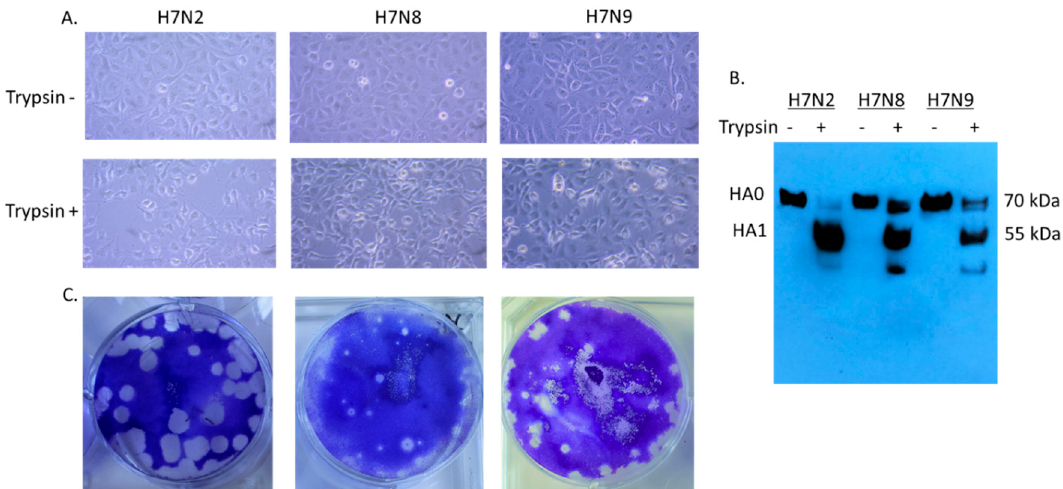
Figure 1. Infectivity of H7N2, H7N8, and H7N9 in MDCK (Madin–Darby canine kidney) cells. MDCK cells were individually infected with H7N2, H7N8, and H7N9 (MOI of 0.1 PFU/cell) in the presence or absence of trypsin. After 12 hpi, the infected cells were visualized directly by photomicroscopy, (20X) ( A ). Collected cell lysates were subjected to Western blot analysis ( B ). Plaque formation of H7 viruses in MDCK cells was conducted by plaque assay ( C ).